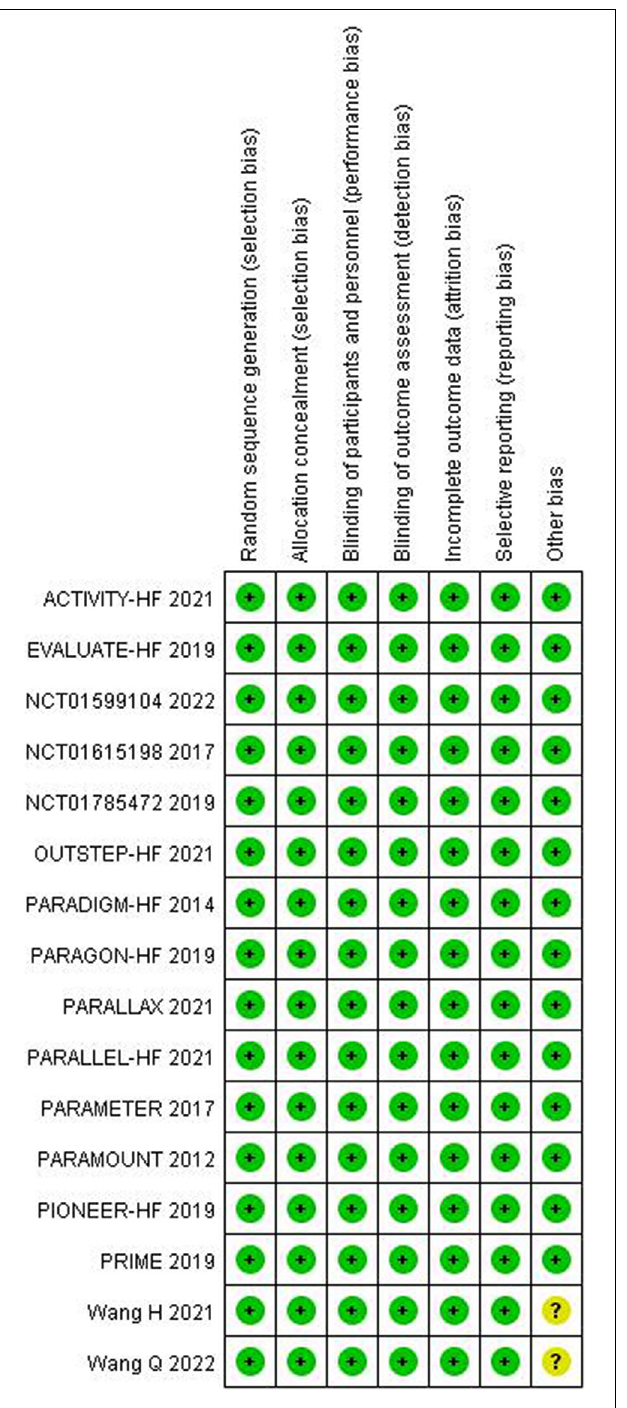
FIGURE 3 | Methodological quality summary: authors’ judgments about each methodological quality.